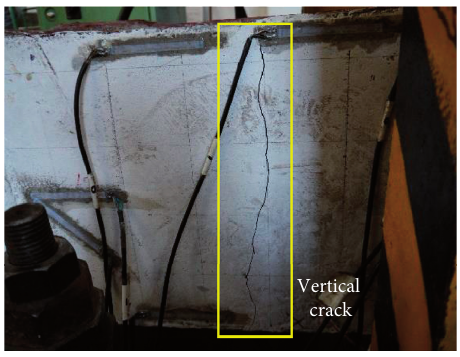
Figure 6: Vertical crack. Figure 7: Vertical crack on side B.